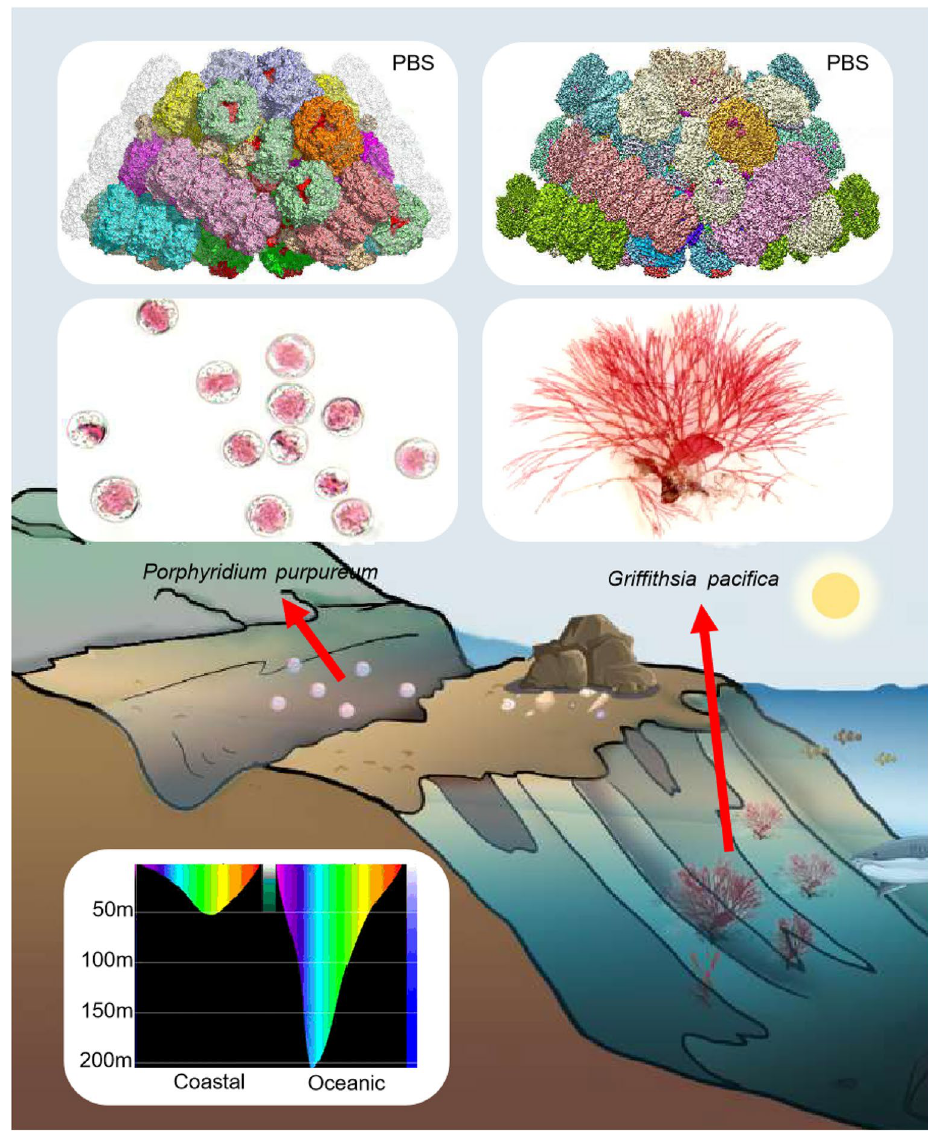
Figure 4. The light environment adaption of G. pacifica and P. purpureum . The top inserted 3D cryo-EM density maps of G. pacifica and P. purpureum. PBSs are reproduced from the work of Zhang et al 19 and Ma et al 20 . The middle insert shows the microscopy images of G. pacifica 29 and P. purpureum 30 . The bottom insert shows the light propagation characteristics in different